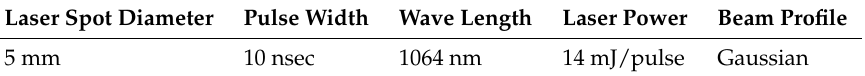
Figure 5. Dimensions of the specimens. Table 1. Parameters of the pulsed-laser